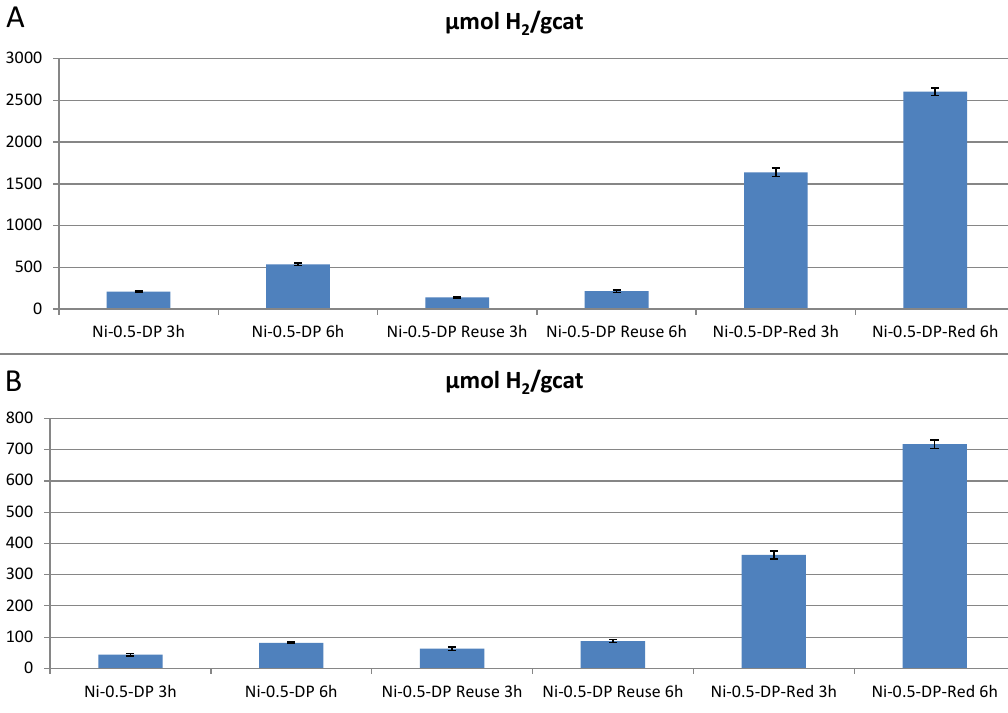
Figure 10. Comparison of hydrogen photocatalytic production on untreated Ni-0.5-DP after the first and second use using UV light ( A ) or solar light ( B ). For the sake of comparison, results obtained for the pre-reduced solid (Ni-0.5-DP-Red) have also been included.